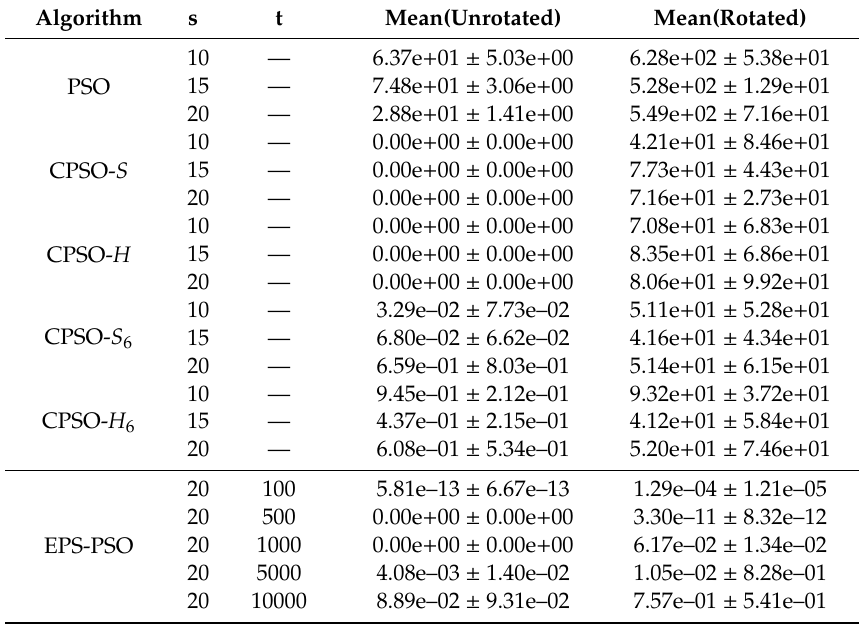
Table 5. Computational results of Rastrigin obtained by using 6 PSO-based algorithms after 2 × 10 5 function evaluations, averaged over 50 independent runs.